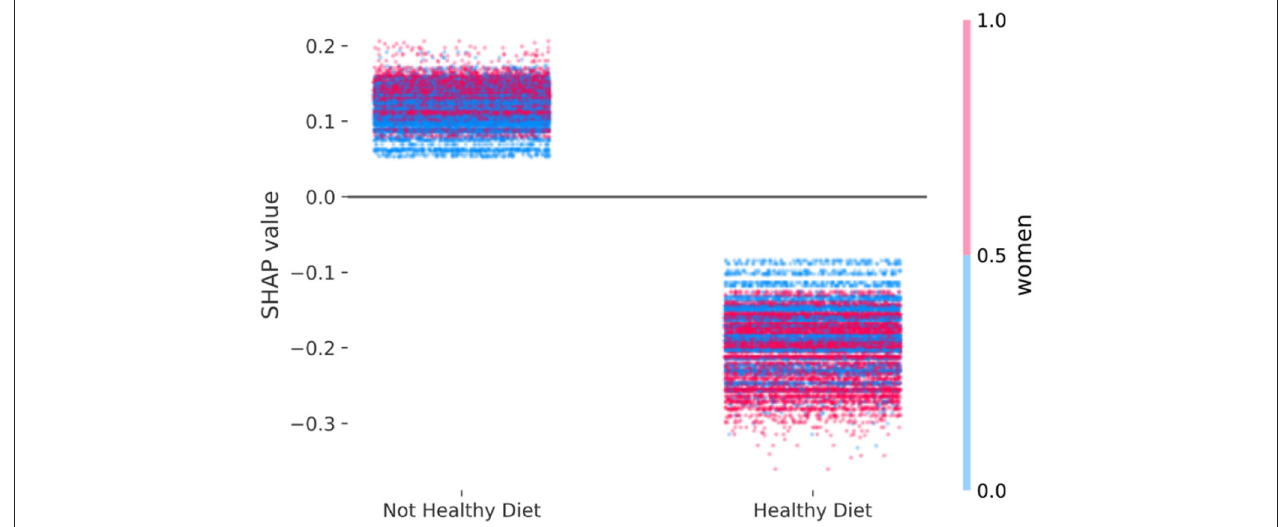
FIGURE 3 | Empirical study—multivariable adjusted association of a healthy diet with mortality risk according to female sex estimated with the SHAP values derived from extreme gradient boosting based on 47,770 participants of the population-based cohorts SMC and COSM. The computed SHAP-based adjusted mortality odds ratio among women (S-OR W = 0.72) is greater than men (S-OR M =